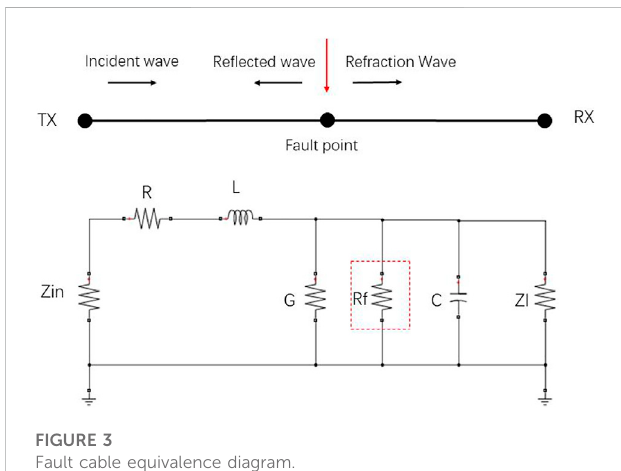
FIGURE 3 Fault cable equivalence